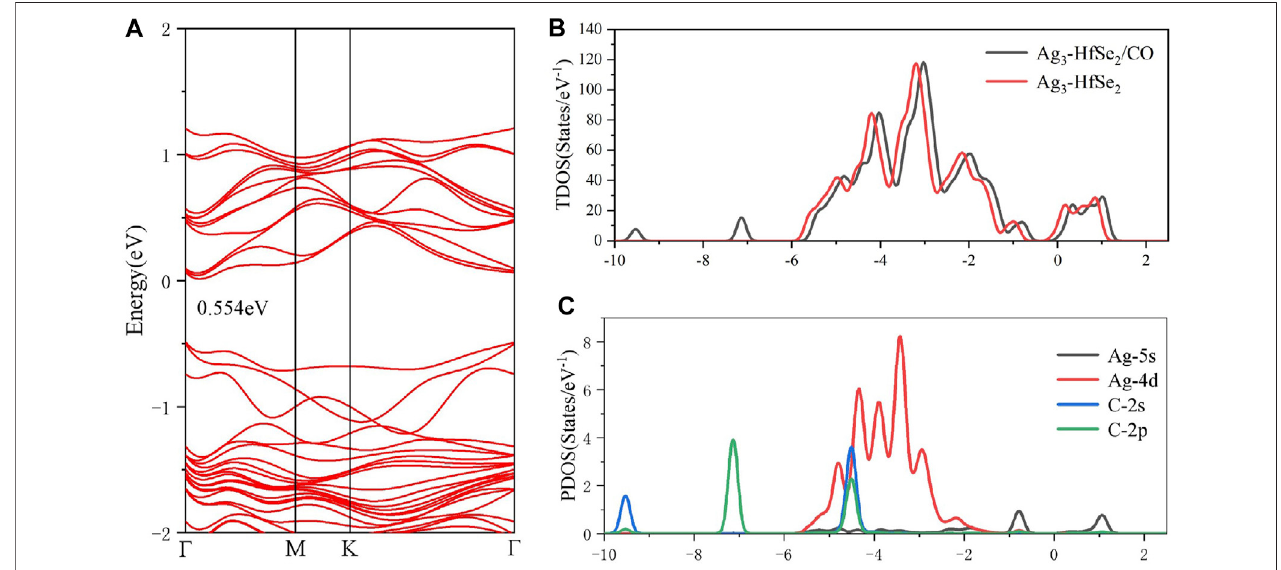
FIGURE 5 | (A) Band structure, (B) TDOS and (C) PDOS of CO molecules ’ adsorption on the Ag 3 -doped HfSe 2 monolayer.